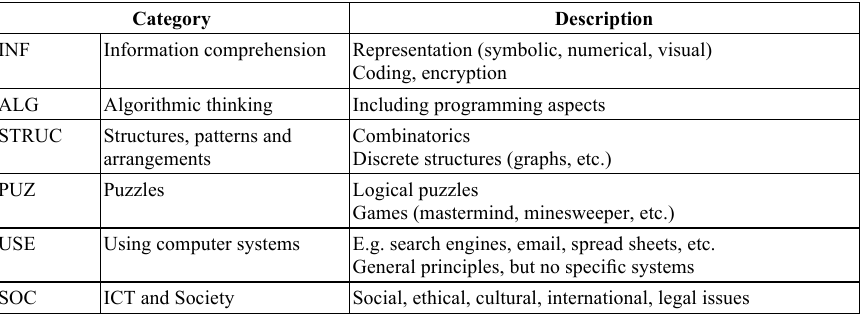
Table 1. Categories of questions from the Bebras contest